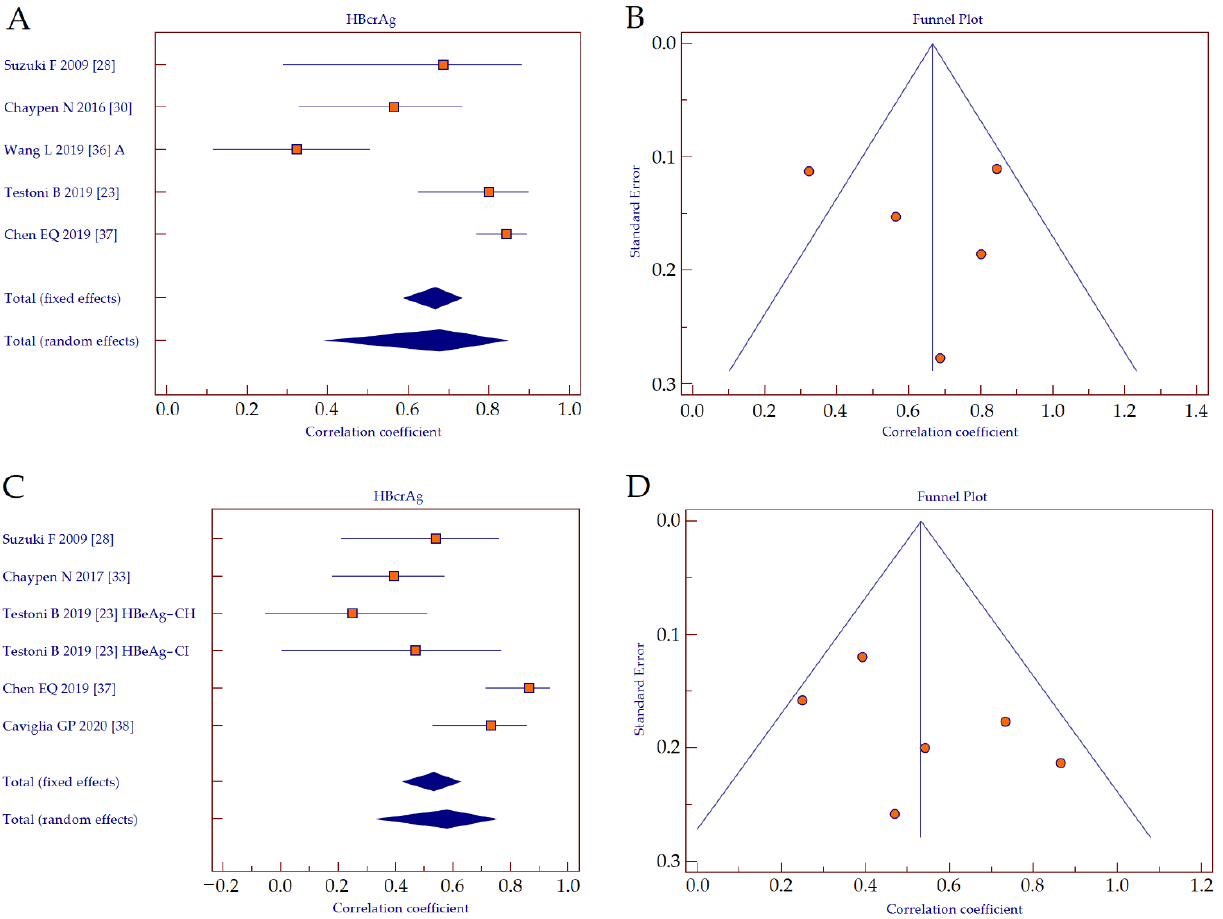
Figure 5. Forest plot ( A ) and funnel plot ( B ) of the correlation between serum HBcrAg and intrahepatic HBV cccDNA in HBeAg-positive patients, and forest plot ( C ) and funnel plot ( D ) of the correlation between serum HBcrAg and intrahepatic HBV cccDNA in HBeAg-negative patients. Abbreviations: hepatitis B core-related antigen (HBcrAg), hepatitis B e antigen (HBeAg), hepatitis B virus (HBV), covalently-closed-circular DNA (cccDNA).